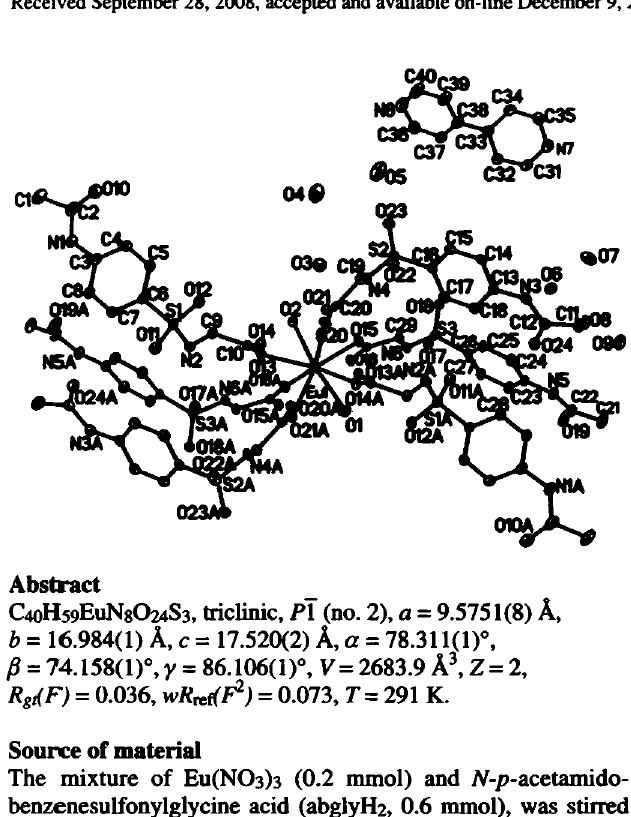
Table 1. Data collection and handling.